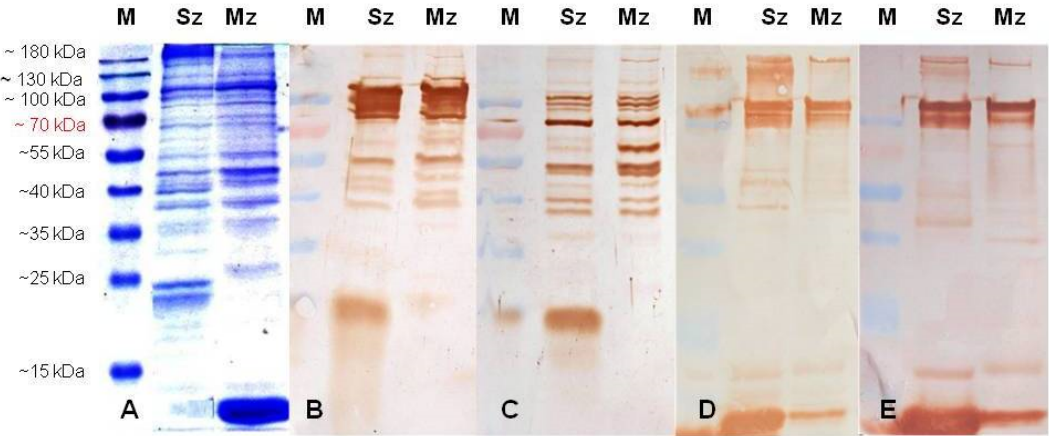
Figure 3. Proteins from the sporozoite (Sz) and the 2nd generation of the merozoite (Mz) of the wild ‐ type E. tenella strain resolved by 12% SDS ‐ PAGE and stained with Coomassie Brilliant Blue ( A ) or probed in immunoblots with antisera (1:100) from two rabbits ( B , C ) and two SPF birds ( D , E ) at 14 days post ‐ immunization with 5.3 × 10 6 whole sporozoites of E. tenella . M: molecular weight ladder in kDa.